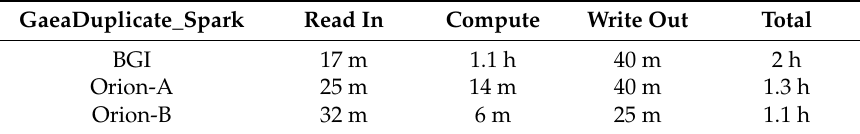
Table 4. Performance decomposition for GaeaDuplicate Spark in different